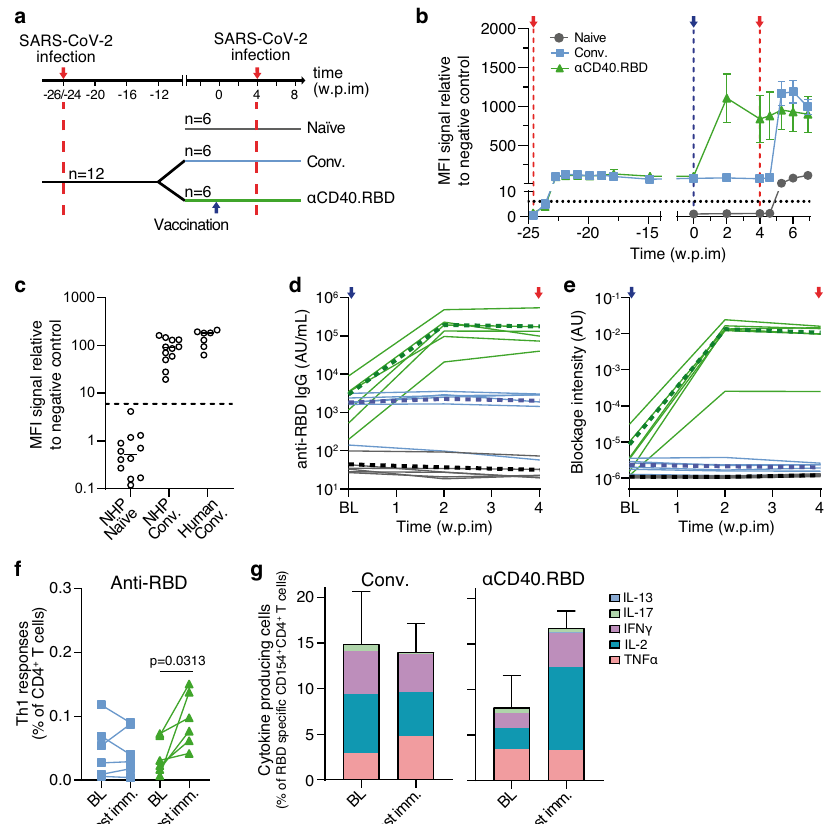
Fig. 2 SARS-CoV-2 speci fi c B- and T-cell responses induced by α CD40.RBD in convalescent NHP. a Study design in cynomolgus macaques. b Relative MFI of IgG binding to SARS-CoV-2 S protein, measured using a Luminex-based serology assay, in serum samples (mean ± SD of 6 animals per group). The red and blue vertical dotted lines indicate viral exposure and vaccination, respectively. c SARS-CoV-2 S protein-speci fi c binding before any exposure to SARS-CoV-2 (week − 26) and on the week of vaccine injection (week 0) in macaques ( n = 12) compared to convalescent humans ( n = 7) sampled 24 weeks after the onset of symptoms. The horizontal dotted line represents the background threshold and bars indicate the mean of each group. d Quanti fi cation of SARS-CoV-2 antibodies against RBD measured in the serum of NHPs using a multiplexed solid-phase chemiluminescence assay. Each plain line indicates the individual values, and the bold dotted lines represent the mean for each experimental group. e Quanti fi cation of antibody-induced inhibition of ACE-2 binding in NHP serum. Symbols are as for d . f Frequency of RBD-speci fi c Th1 CD4 + T cells (CD154 + and IFN- ɣ ± IL-2 ± TNF- α ) in the total CD4 + T cell population for each non-immunized convalescent macaque ( n = 6, blue lines and symbols) and α CD40.RBD-vaccinated convalescent macaque ( n = 6, green lines and symbols). PBMC were stimulated overnight with SARS-CoV-2 RBD overlapping peptide pools. Time points in each experimental group were compared using the Wilcoxon signed rank test. g Frequency of cytokine producing cells in the RBD-speci fi c CD4 + T cells (CD154 + ) for non-immunized convalescent macaque (left) and α CD40.RBD-vaccinated convalescent macaque (right). Each bar indicated the mean of the 6 vaccinated convalescent macaques± SD. Distribution of cytokines is indicated within each bar. BL: Baseline approximately 1 week before immunization; “ Post imm. ” : Two weeks post